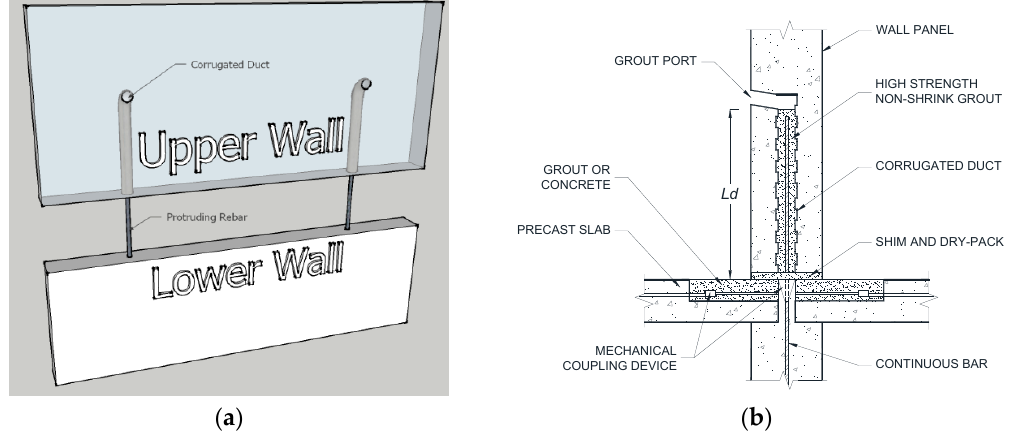
Figure 1. ( a ) Typical grouted corrugated duct connection; ( b ) schematic diagram of grouted connections in precast walls (reused with permission [3]).